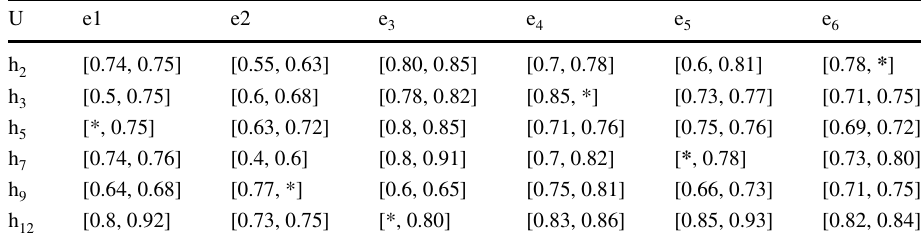
Table 3 Incomplete interval- valued fuzzy soft set U